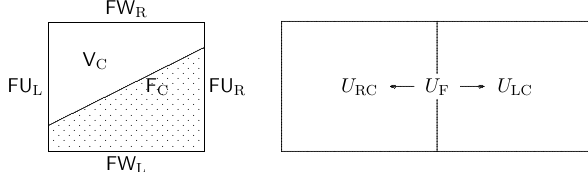
where y n is a given approximation at y ( t ) at time t n and subsequently y n +1 at time t n +1 = t n + τ . In addition J is an approximation to the Jacobian matrix ∂F/∂y . A Rosenbrock method is therefore fully described by the two matrices 54 ( α ij ) , Γ = ( γ ij ) and the parameter γ . Figure 3. Cut cell with face and volume area information (left) and arrangement of face and cell Figure 3. Cut cell with face and volume area information (left) and Among the available methods are a second order two stage centered momentum (right). arrangement of face- and cell-centered momentum method after Lanser et al. (2001). Fig. 3. Stencil for third-order approximation.